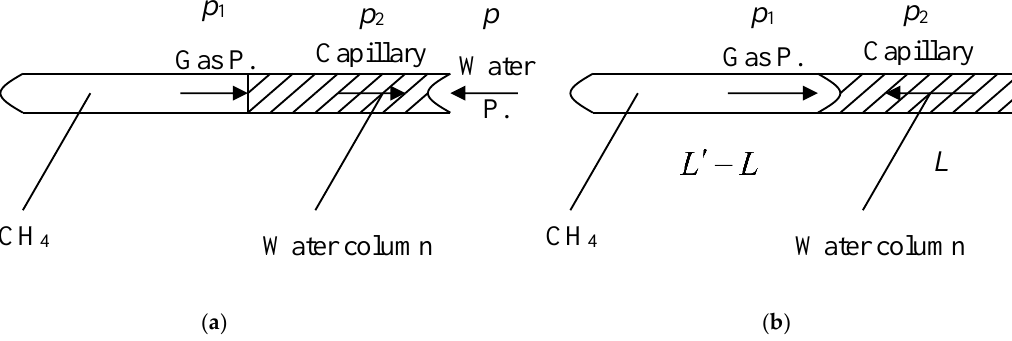
Figure 1. Schematic to show the coupling between liquid and gas. ( a ) Water injection process; ( b ) Water pressure unloaded process.